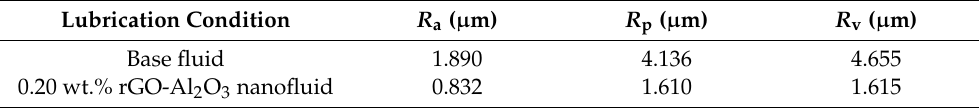
Figure 8. Surface topography and cross-section depth profile of wear track on the disk lubricated by ( a ) base fluid and ( b ) rGO-Al 2 O 3 nanofluid. Table 10. The line roughness of wear track lubricated with base fluid and 0.20 wt.% rGO-Al 2 O 3